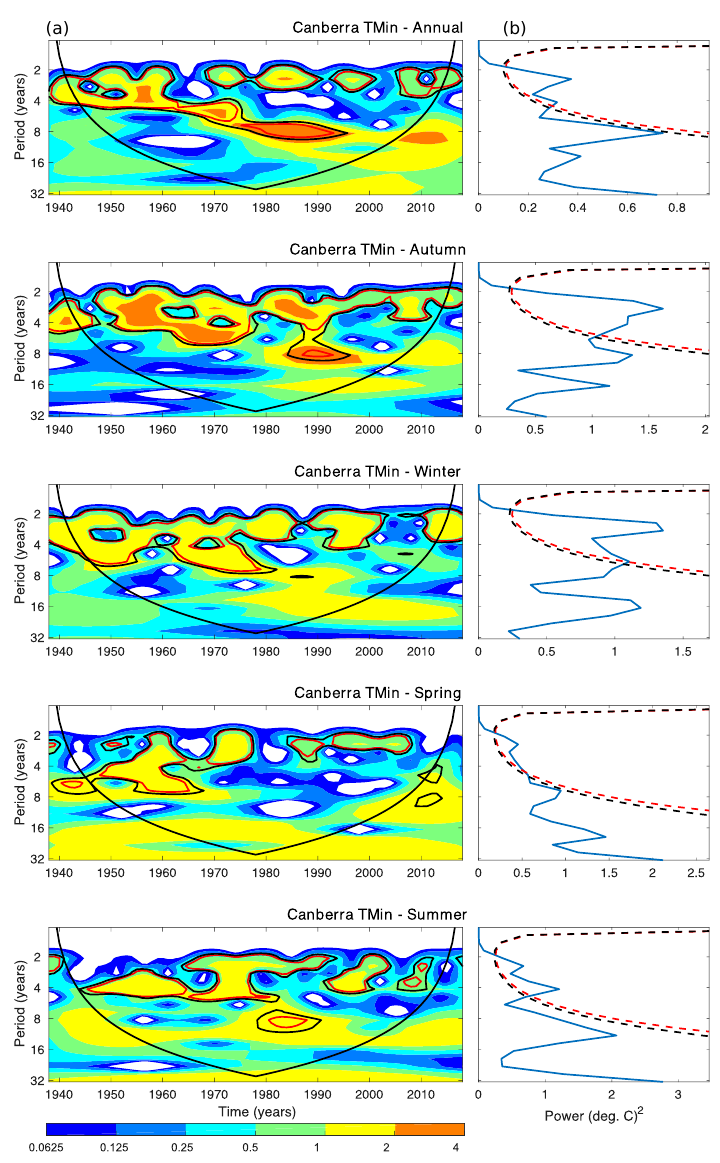
Figure 8. ( a ) Wavelet power spectra and ( b ) global power spectra for TMin, with low and high values in the power spectra indicating low and high periodicity, respectively, the cone of influence and statistical significance bands as already explained in Figure